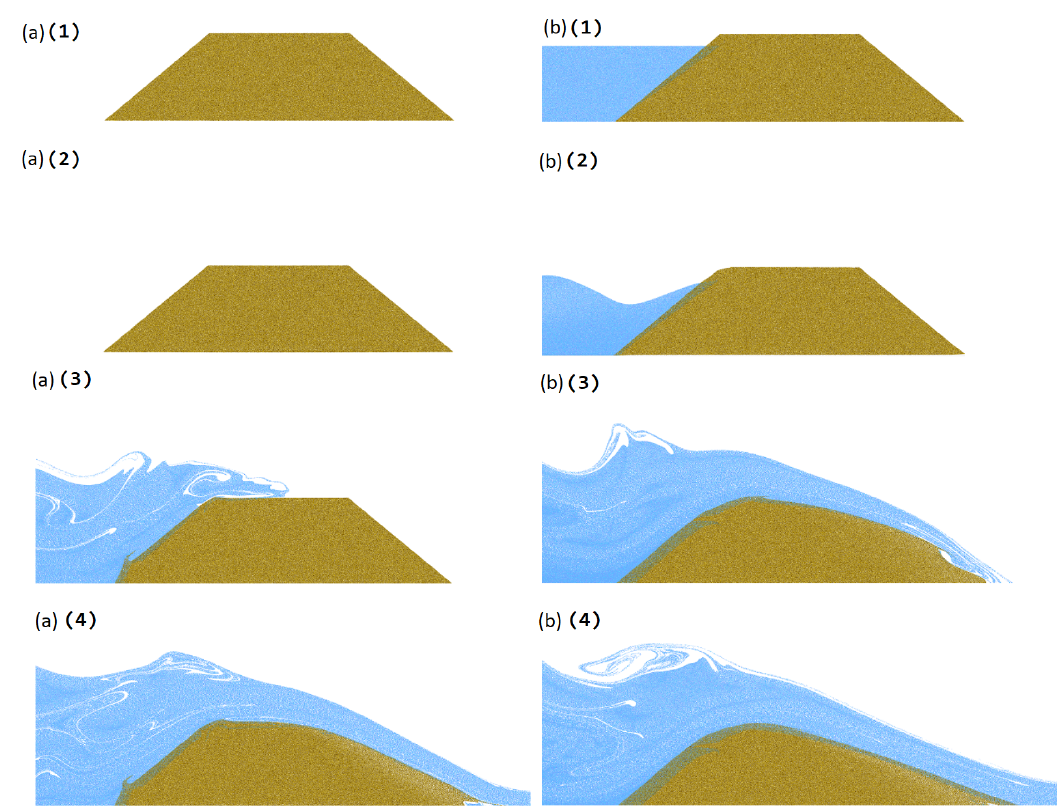
Figure 5. The overtopping dam breach simulation with an empty ( a ) and full ( b ) reservoir at different timestamps